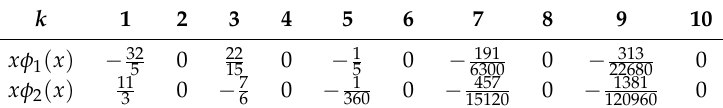
Table 3. The differential transform of x φ i ( x ) , i = 1,2 for Example 6.